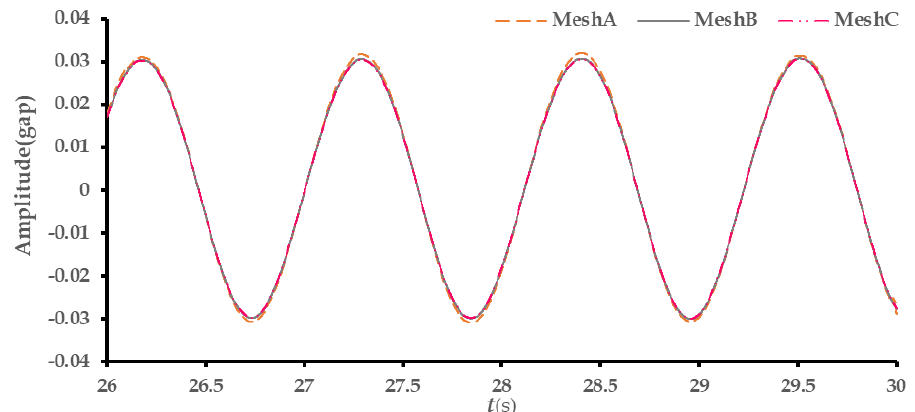
Figure 4. Time histories of the wave elevation in the gap obtained using three different meshes for h 2 / h 1 = 1 and T = 1.1108 s.